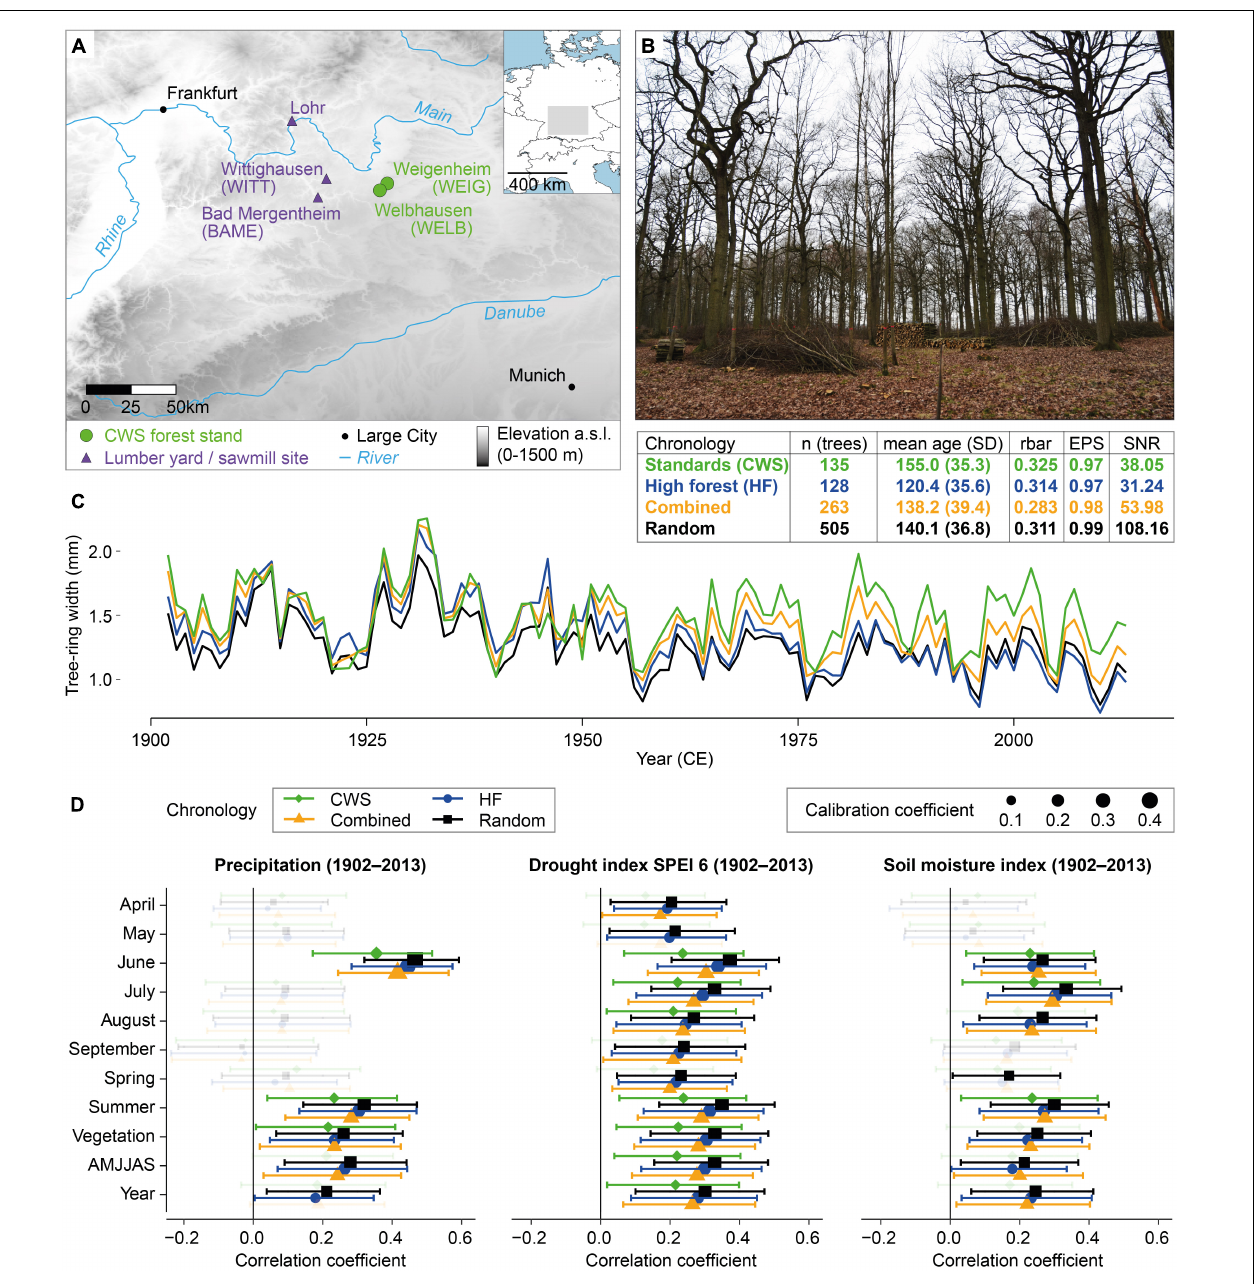
FIGURE 1 | (A) Location of sampled forest stands for coppice-with-standards (CWS; green) and lumber yards/sawmills (purple). (B) Example of CWS forest structure in Welbhausen (during understory coppice in 2018). (C) Average tree-ring chronologies (raw TRW) and statistics (table) on the detrended tree-ring series. mean age in years; SD, standard deviation; rbar, mean correlation between individual tree series; EPS, expressed population signal and SNR, signal to noise ratio. (D) Climate-growth correlations for all detrended chronologies (using a 30-year spline with a 50% frequency cut off after removing autocorrelation) with hydroclimate parameters for the period 1902–2013. Bars denote upper and lower confidence intervals. Transparent points and bars indicate non-significant correlations. CWS: coppice with standards, HF: high forests, combined: dataset containing both the CWS and HF datasets, random: the random dataset of oak tree ring series collected from lumber yards and a veneer company in the